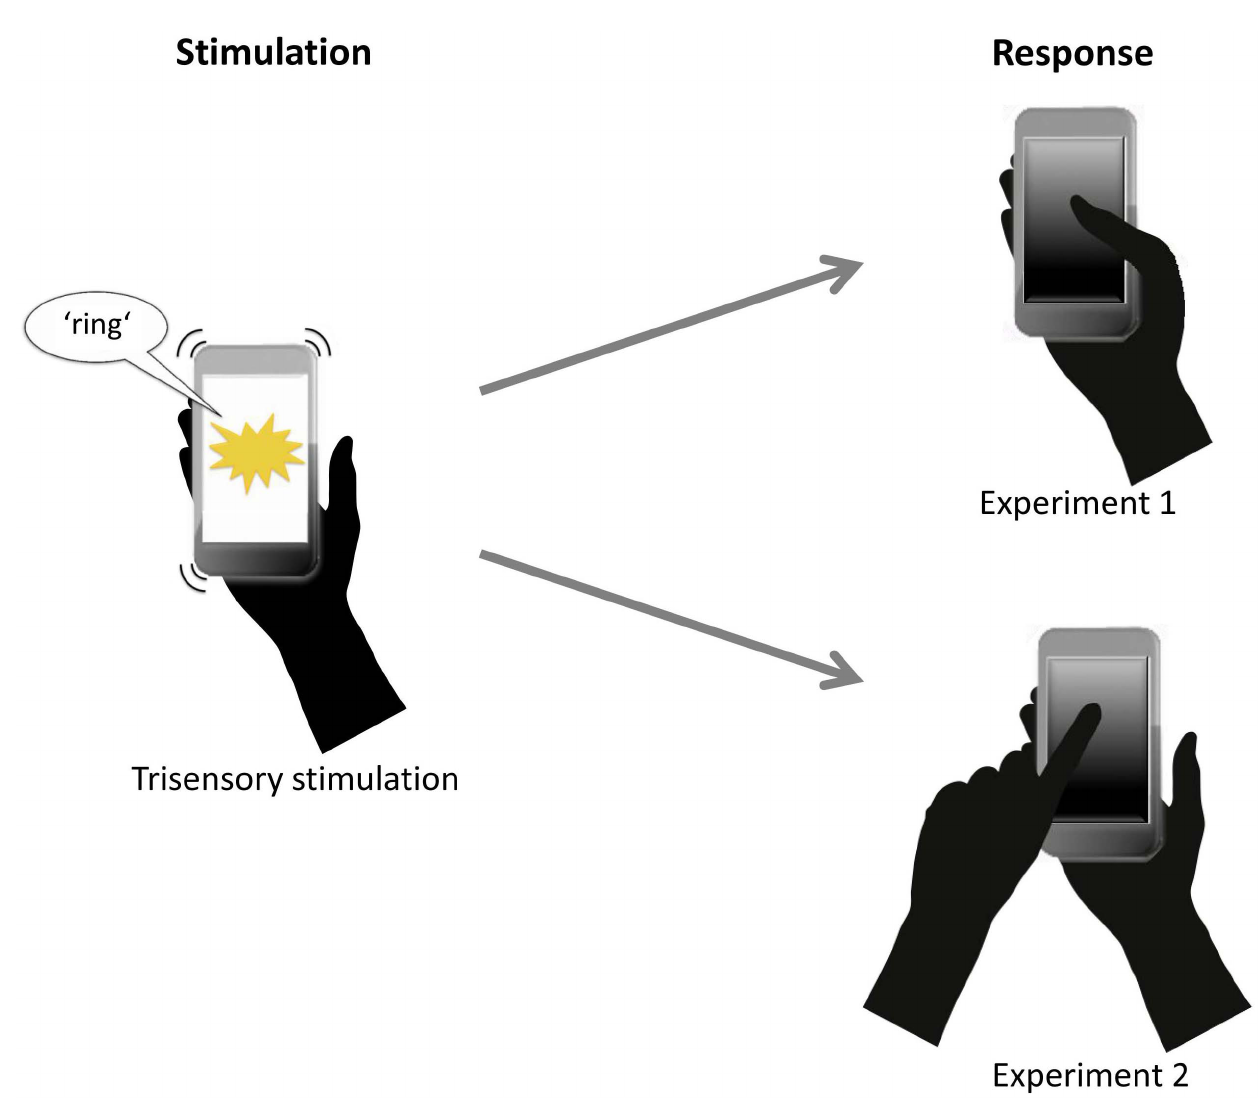
Figure 1. Illustration of Experiments 1 and 2. Participants were presented with different unisensory and multisensory smartphone stimuli. They were instructed to touch the phone’s display using either the stimulated hand (Experiment 1, upper right row) or the non-stimulated hand (Experiment 2, lower right row) in response to the appearance of any stimulus.